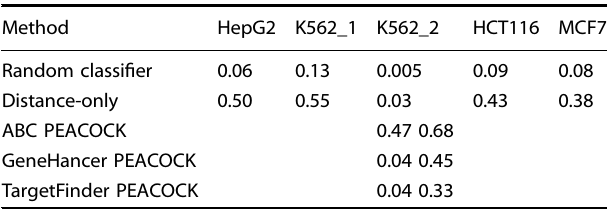
Fig. 3 Predicted cell type-speci fi c scores for all possible enhancer-gene links in cis. All possible cis enhancer-gene links (enhancer and gene pairs located <1 Mb apart) are separated by those predicted in PEREGRINE (magenta), and those that were not predicted in PEREGRINE (purple) for HepG2 ( A ) and HCT116 ( B ) cell-speci fi c data. The histograms of each population are overlaid. The mean of each population ’ s cell type-speci fi c scores is plotted as a vertical bar along the histogram. A shows the distribution of the non-zero PEACOCK scores, which makes up about 84% of pairs genome-wide. B shows the overall distribution, as no predictions were scored as zero. Distributions for scores in K562 and MCF7 were nearly identical to that of HepG2 and so are not shown here (Supplementary Figs. 7 – 12 of Supplementary materials). Two- sample KS tests show that for all cell types, the distributions of PEREGRINE cis enhancer-gene links are statistically signi fi cantly different than the distributions of the non-PEREGRINE cis enhancer-gene pairs ( p < 2.2e-16), and in all cell lines the score means are higher for PEREGRINE enhancer-gene links. Table 4. Prediction performance for other